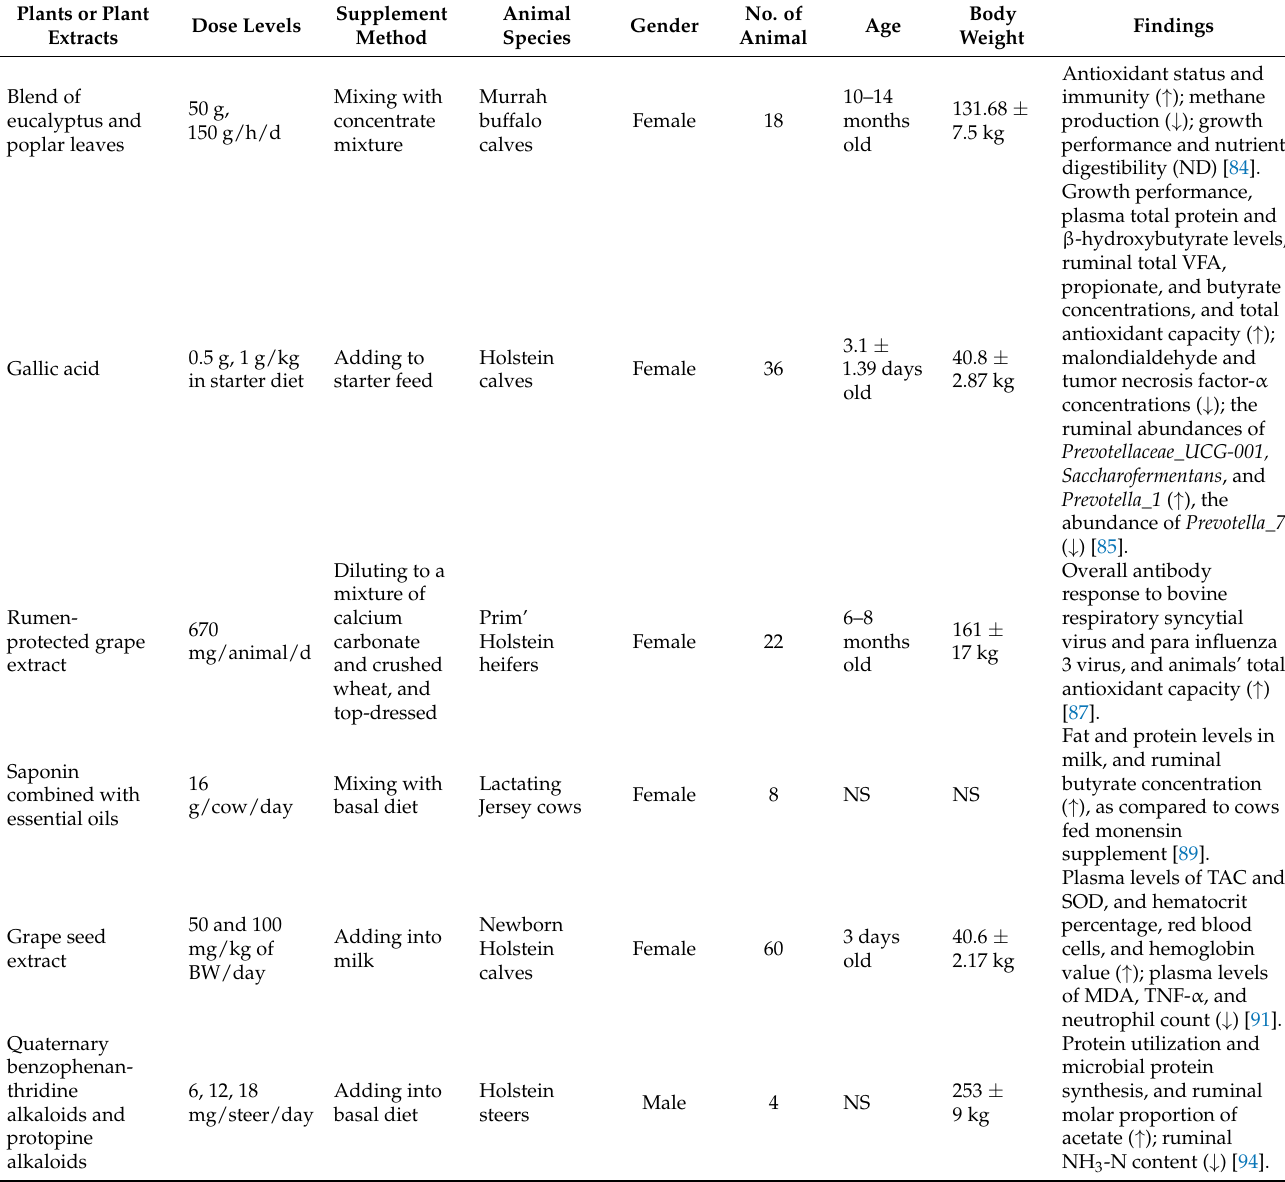
Table 2. Effects of plant extracts on growth performance, feed utilization, antioxidants capability, and animal products in